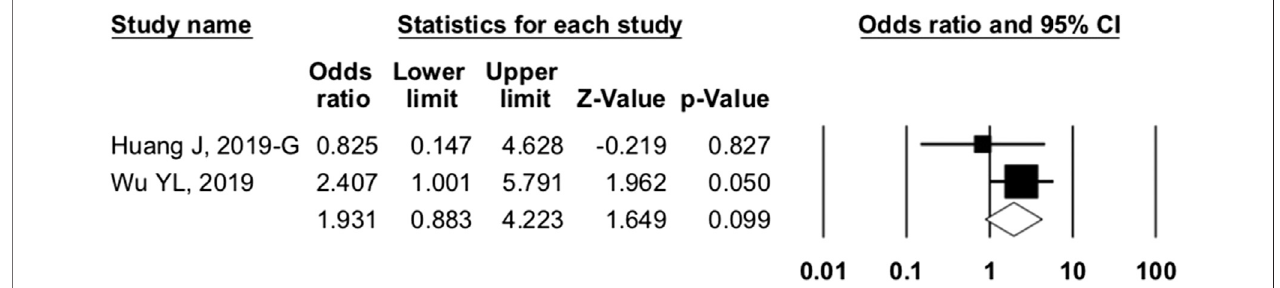
FIGURE 6 | Comparison of programmed cell death ligand 1 – positive and programmed cell death ligand 1 – negative patients. Our study showed that PD-L1 expression (cutoff value: 1%) was not associated with overall response rate (odds ratio (cid:1) 1.931, 95% CI: 0.883 – 4.223, p (cid:1) 0.099).